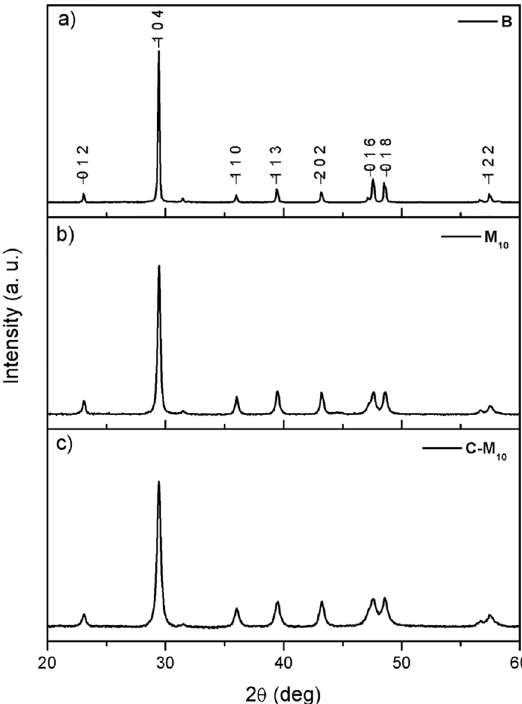
extracted from 3 ), c) and after being ball 10 10